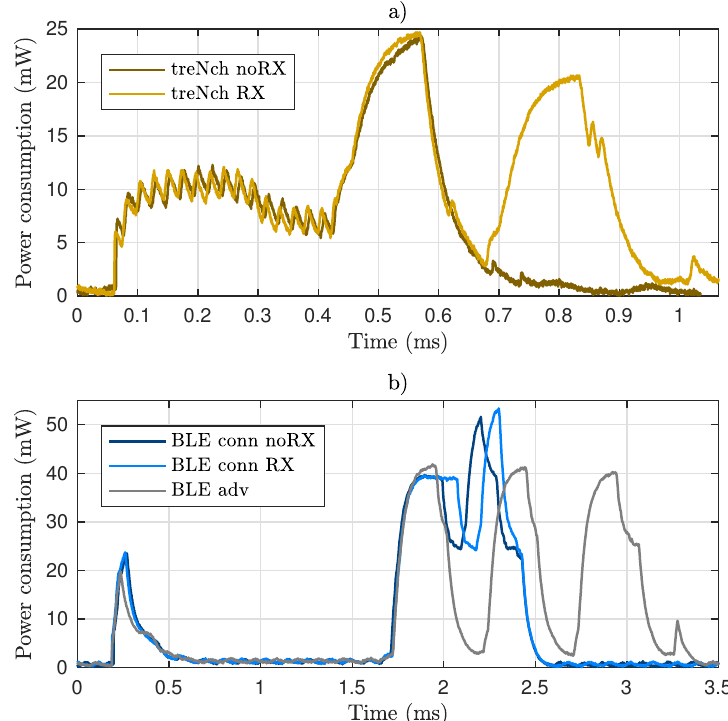
Figure 6. Measurement of power consumption in time during active phase. Most general cases of treNch ( a ) and BLE ( b ).